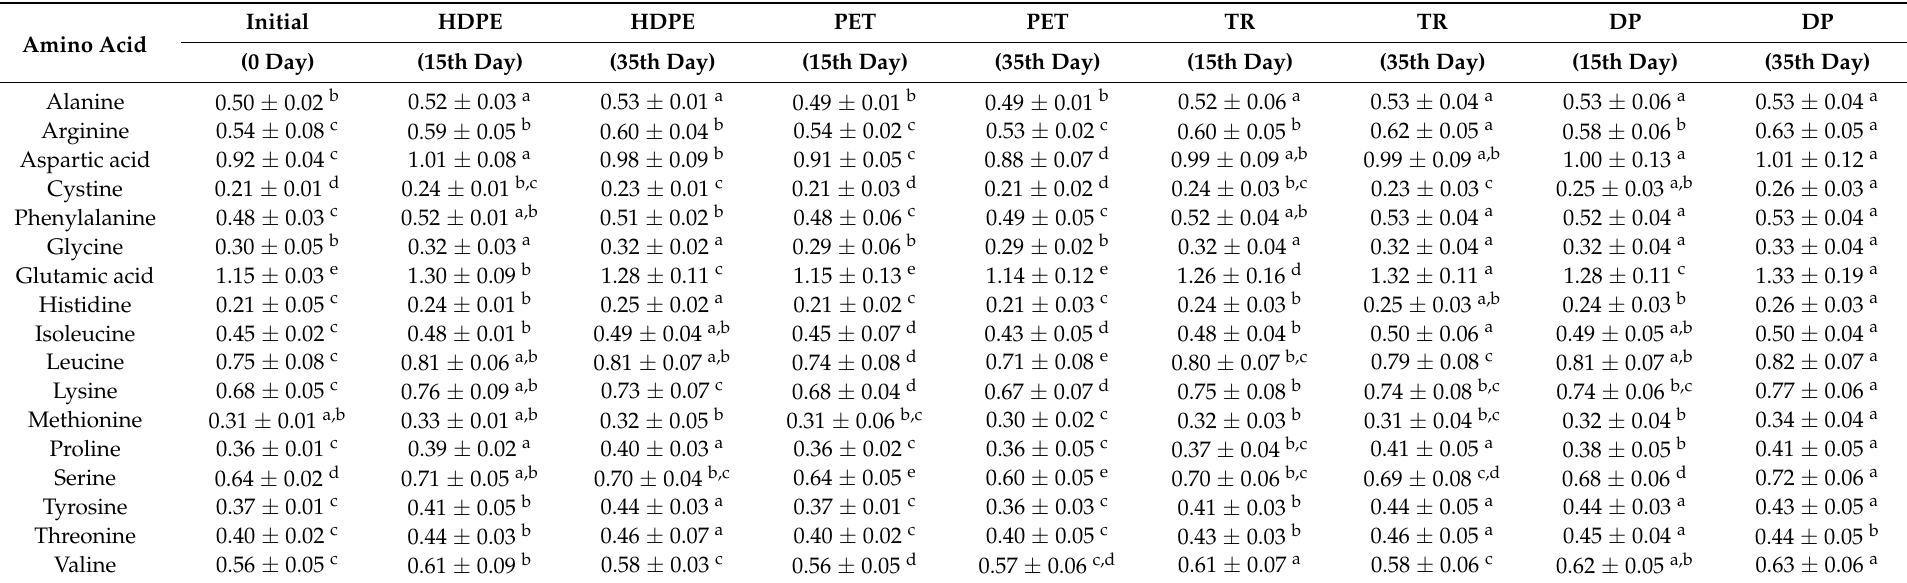
Table A2. Amino acid profile of whole eggs in relation to the time of storage and type of packaging, g 100 g − 1